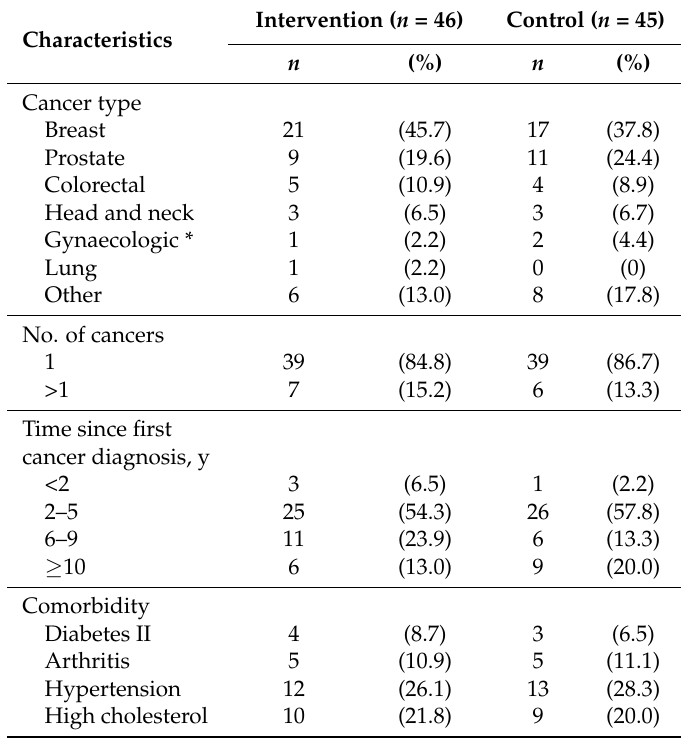
Table 2. Cancer specific characteristic and comorbidities of